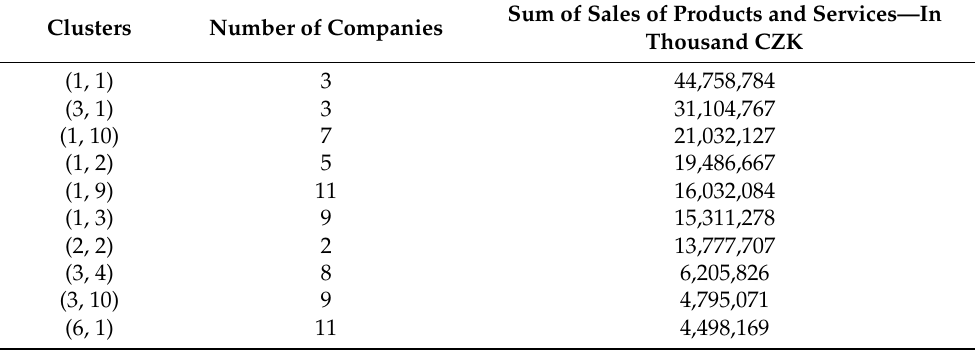
Table 20. Table of ten clusters with the highest total sum of fixed assets for the year 2018. Sum of Sales of Products and Services—In Clusters Number of Companies Clusters